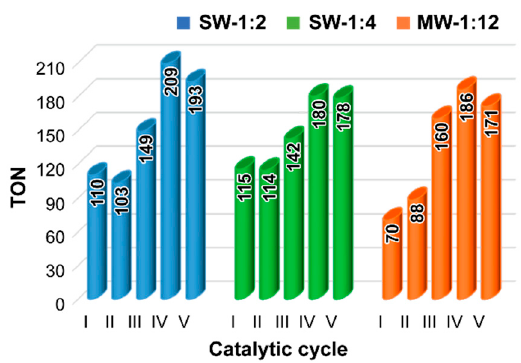
Figure 3. Recycling tests of catalysts SW-1:2, SW-1:4, and MW-1:12. Reaction conditions: styrene oxide (209.7 mmol), CO 2 (40 bar), catalyst (300 mg; 0.8 mmol of SW-1:2, 300 mg; 0.9 mmol of SW-1:4 , or 208 mg; 0.8 mmol of MW-1:12), 150 °C, 3 h. (see also Tables S4–S6).